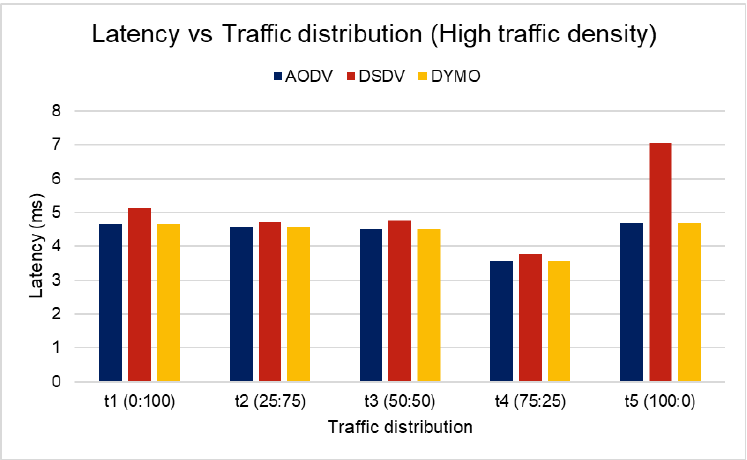
Figure 16. Latency graph for high traffic density with varying traffic